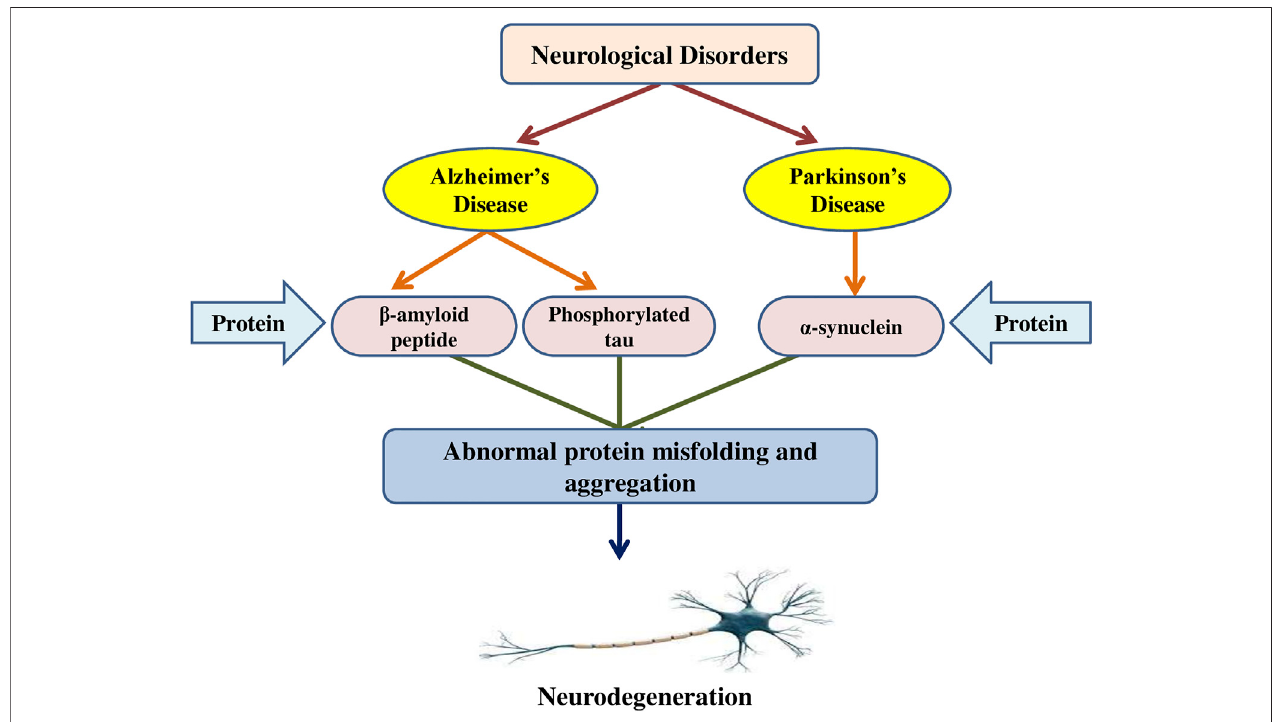
FIGURE 2 | The mechanism of protein aggregation in neurodegenerative